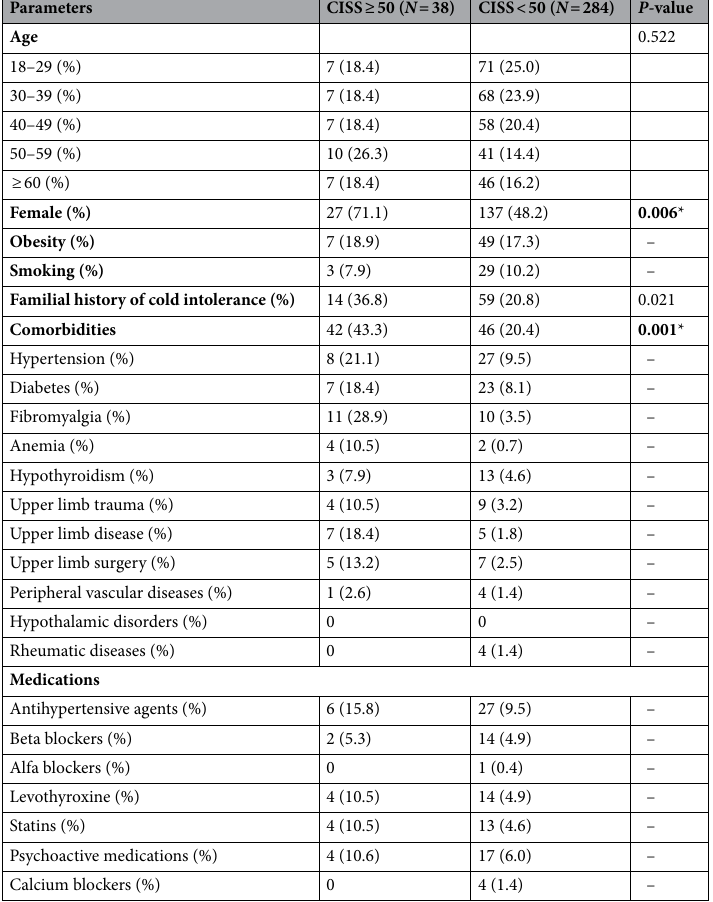
Table 3. Frequency of cold intolerance in different groups. *After Bonferroni correction, they remained at significant levels. CISS Cold Intolerance Symptom